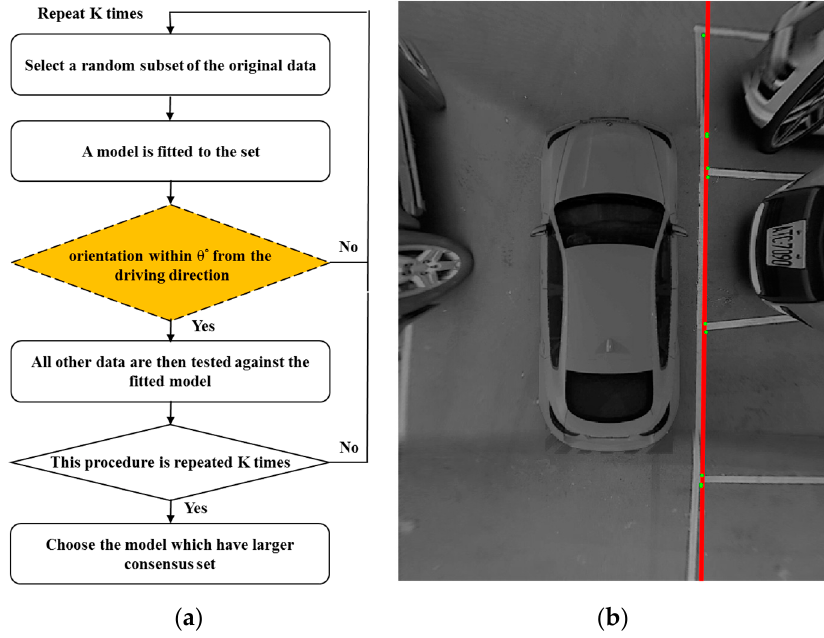
Figure 9. Lane boundary line recognition. ( a ) Algorithm; ( b ) Results.